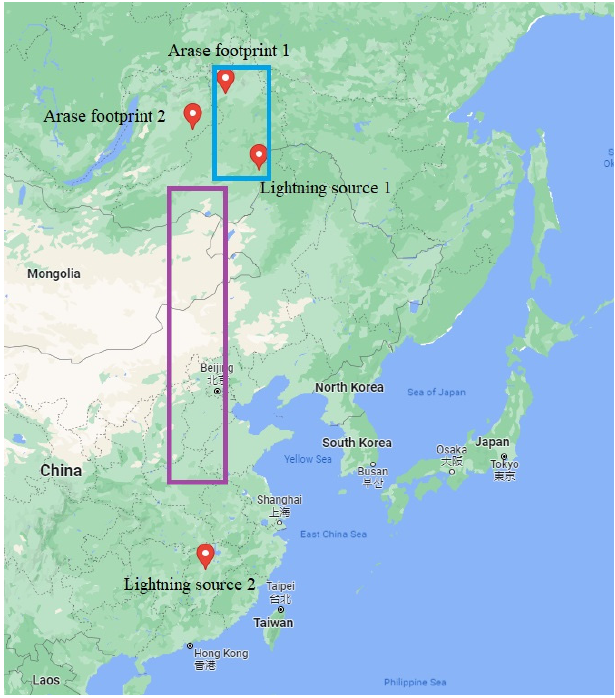
Figure 6. Position of the Arase footprint and the lightning source point.